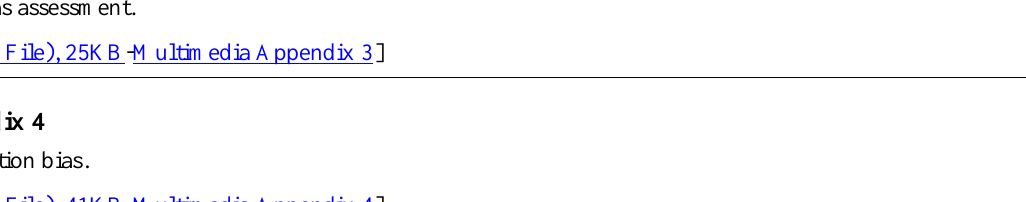
Table for the risk of bias